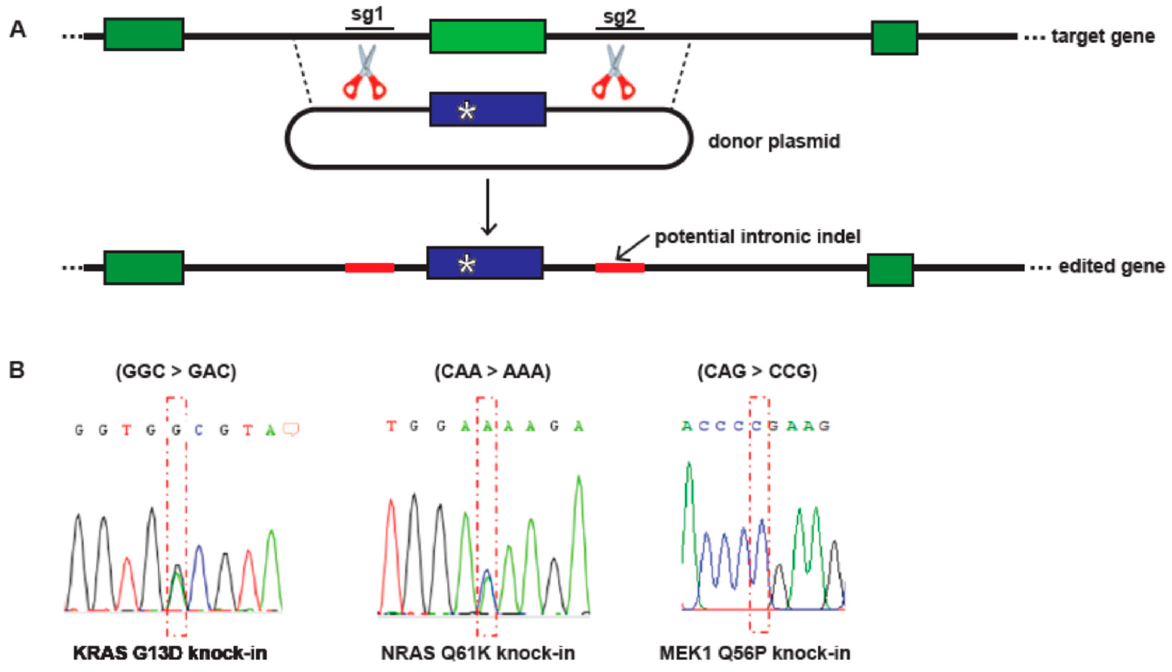
Figure 1. CRISPR/Cas9 engineering of isogenic A375 models of drug-resistant melanoma. ( A ) Sche- matic diagram of the CRISPR/Cas9 editing strategy used for the introduction of point mutations associated with BRAF and MEK inhibitor resistance into A375 melanoma cells. Two guide RNAs in complex with Cas9 (sg1 and sg2, scissors) were used to create double-stranded breaks in the intronic regions (black lines) to either side of the target exon (black box). A donor plasmid containing a copy of the target exon with the desired point mutation (star) and flanking intronic sequences was used as a repair template. This strategy ensures that any indels resulting from imperfect sequence repair at the Cas9 cut sites (red lines) are spliced out during mRNA processing and do not affect the re- sulting cellular protein; ( B ) Sanger sequencing of genomic DNA from the resulting KRAS G13D heterozygous (left), NRAS Q61K heterozygous (middle), and MEK1 Q56P homozygous (right) A375 isogenic lines.